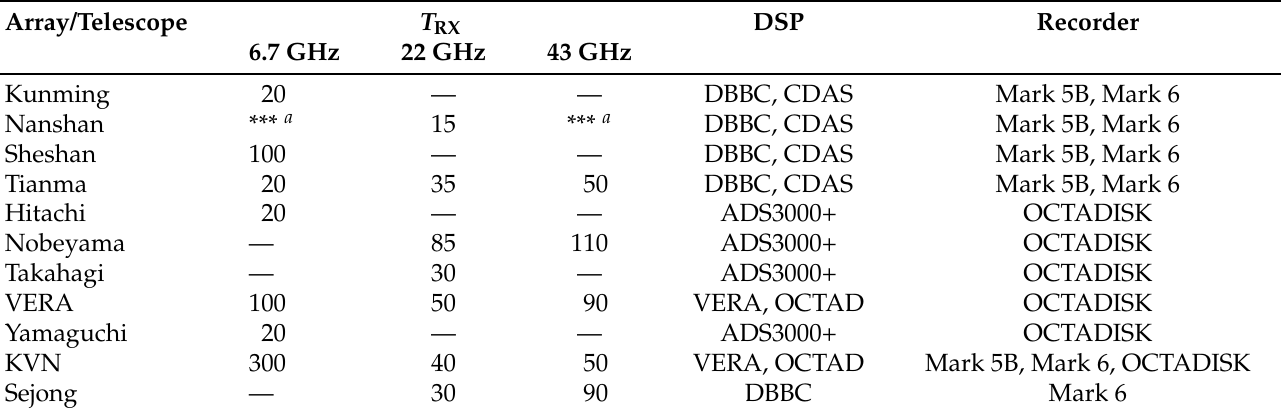
Table 2. Performance of the receiver and the data acquisition system at each EAVN station.